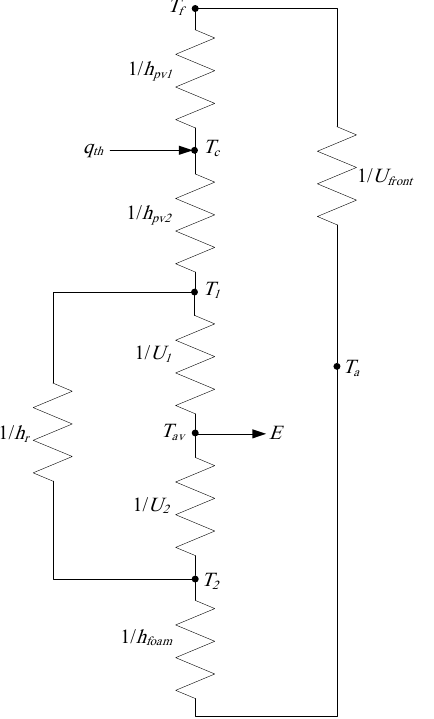
Figure 2. New thermal network for the PV/PCM–metal foam system. Applying the energy balance on each element of the thermal network of Figure 2, the average temperature of PV frontside ( 𝑇 (cid:3033) ), PV cell ( 𝑇 (cid:3030) ), PCM upper layer ( 𝑇 (cid:2869) ), PCM lower layer ( 𝑇 (cid:2870) ), and whole PCM component ( 𝑇 (cid:3028)(cid:3049) ) are respectively found as: